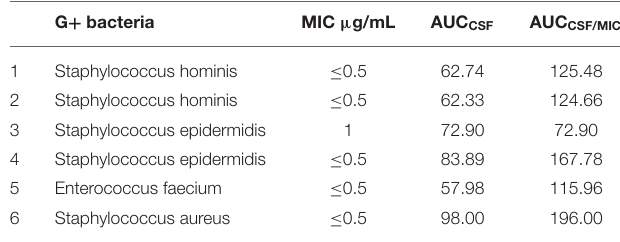
TABLE 2 | Distribution and characteristics of G + bacteria in cerebrospinal fluid